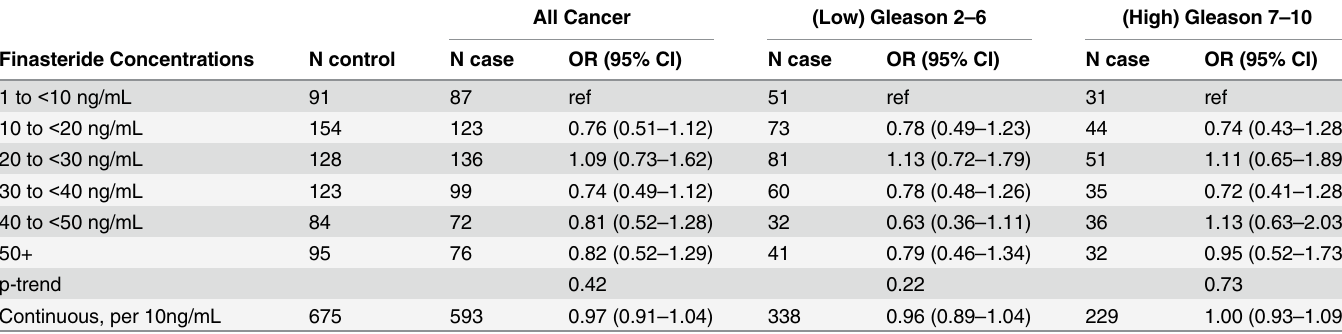
Table 3. Associations of finasteride concentrations with prostate cancer risk in PCPT, overall and stratified by cancer